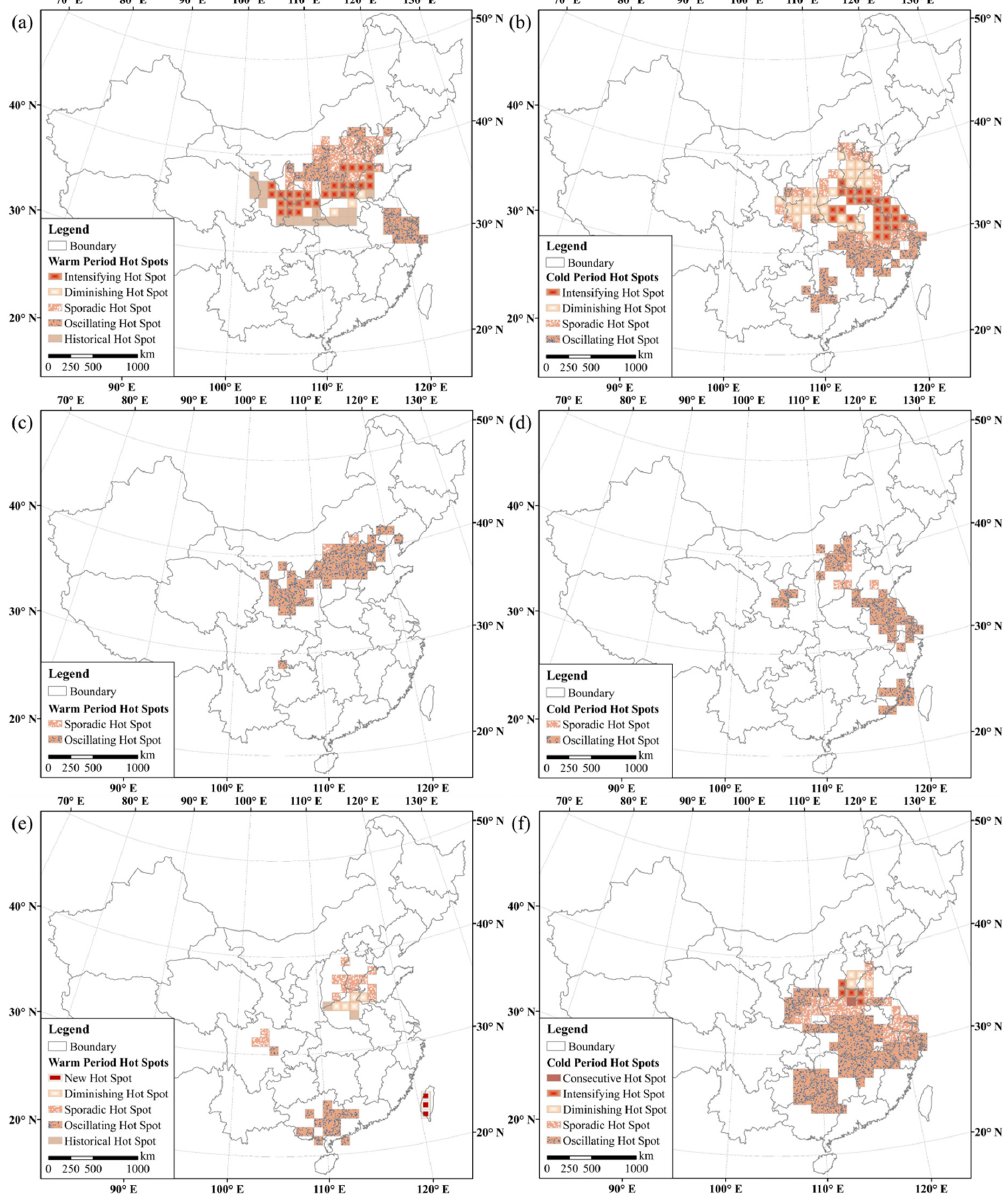
Figure 3. EHSA patterns of all warm and cold periods for three types of war: ( a , b ) All war, ( c , d ) agri-nomadic conflict, and ( e , f ) rebellion. Only significant hot spots ( p < 0.05) are shown (the same as Figure